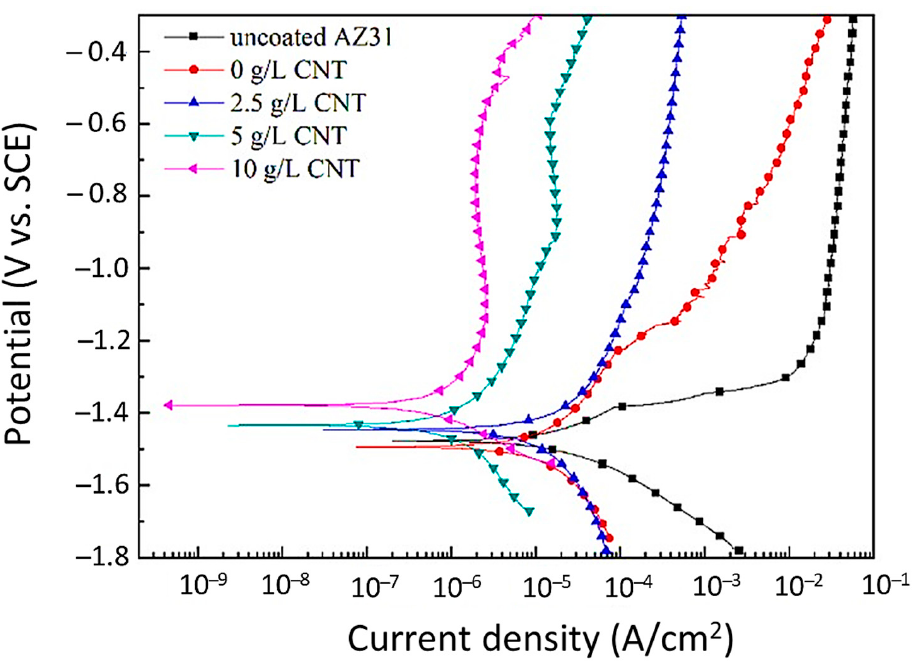
Figure 12. Potentiodynamic polarization curves of PEO coatings developed. Reproduced with permission from [129]. Copyright MDPI, 2018.